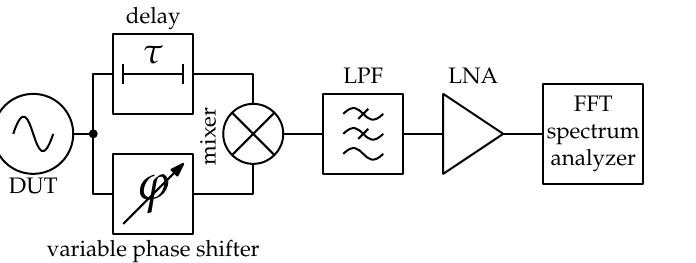
Figure 1. Conceptual block diagram of the delay line method. The phase shifter is optional, but in practical cases, it is more convenient than tuning the delay